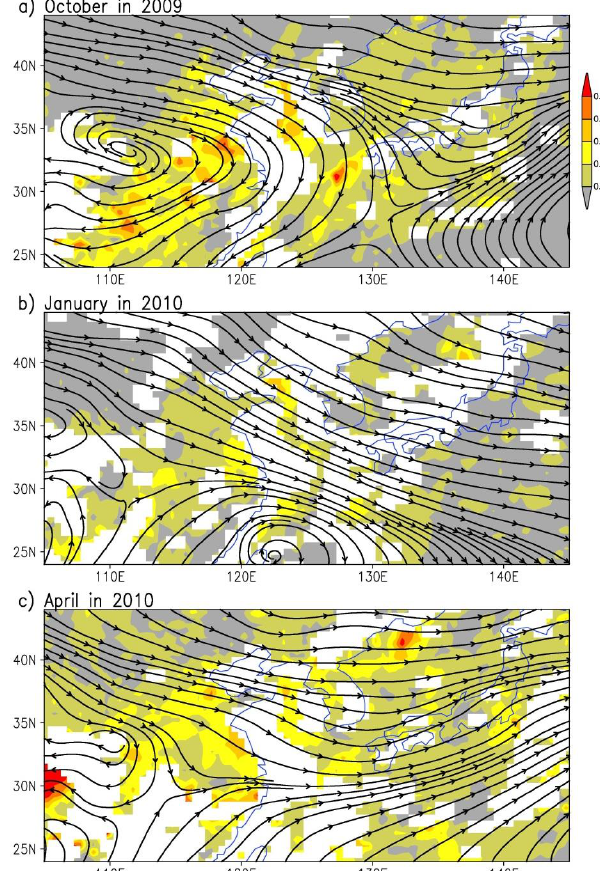
Fig. 3. 850hPa wind stream from the ERA Interim Reanalysis (Dee Figure 3. 850 hPa wind stream from the ERA Interim Reanalysis (Dee et al., 2011) and MISR et al., 2011) and MISR (Multi-angle Imaging Spectro-Radiometer) (Multi-angle Imaging Spectro-Radiometer) small-mode AOD at 555nm. small-mode AOD at